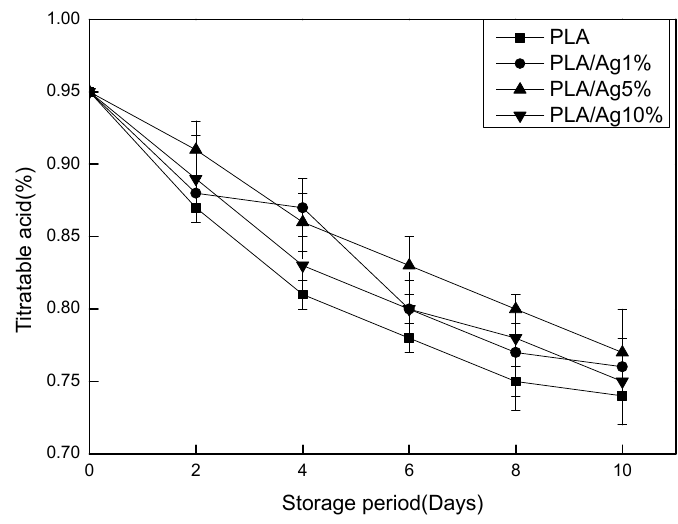
Figure 4. Effect of different concentration of nano-Ag active packages on titratable acid of strawberry stored at 4 ± 1 °C for 10 days. Data are presented as mean ± standard deviation.